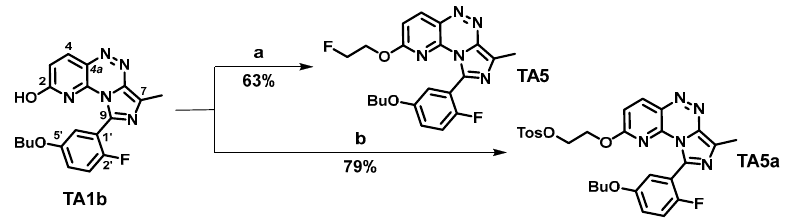
Table 1. IC 50 values of the novel 2-fluoroethoxy derivative TA5 for the inhibition of human PDE2A and human PDE10A compared to our already published data for the lead compound TA1 and the PDE2A ligands TA2 – 4 [13,19,20].